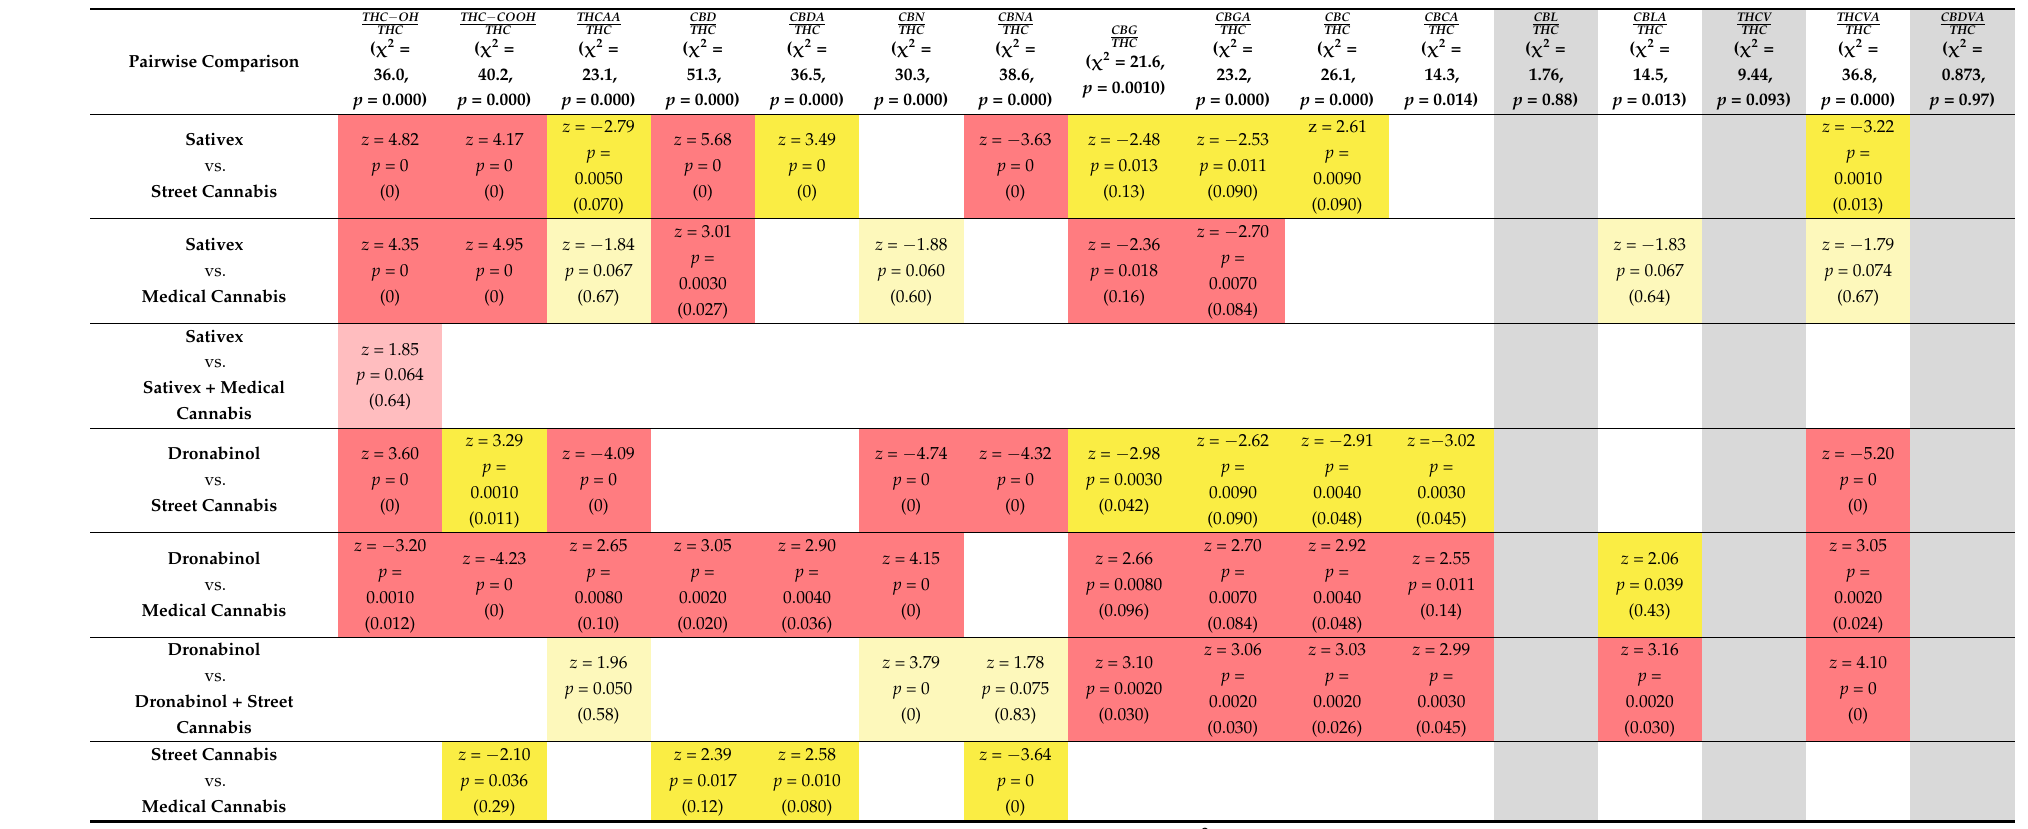
Table 2. Results of the Kruskal–Wallis test for selected pairwise